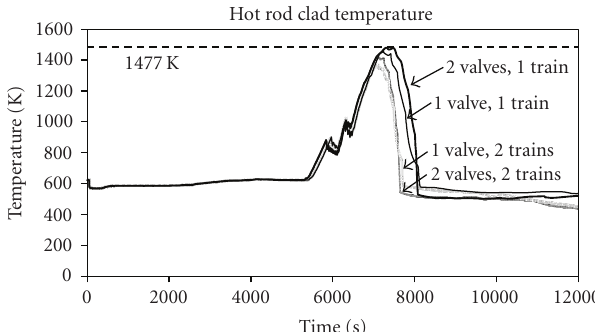
Figure 12: Hot rod clad temperature (F&B availability study).